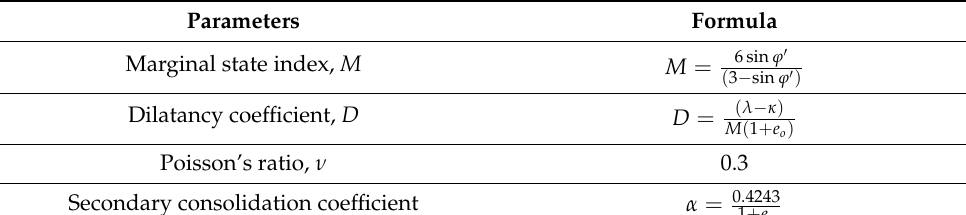
Table 4. Parameters used for the finite element method.